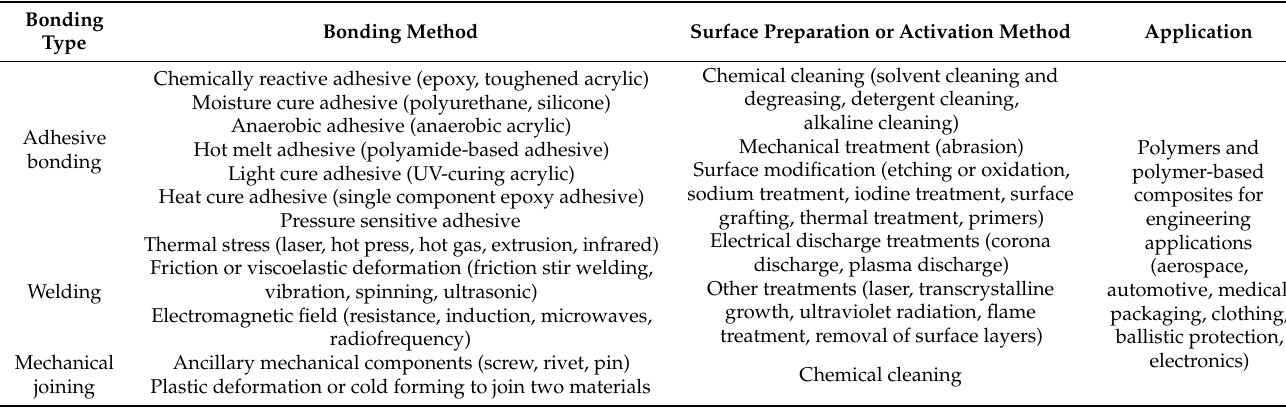
Table 1. Main bonding technologies to bond two polymers or a polymer to another material (non-exhaustive information), based on the reviews [13–17] (Copyright (2021), with permission from Springer